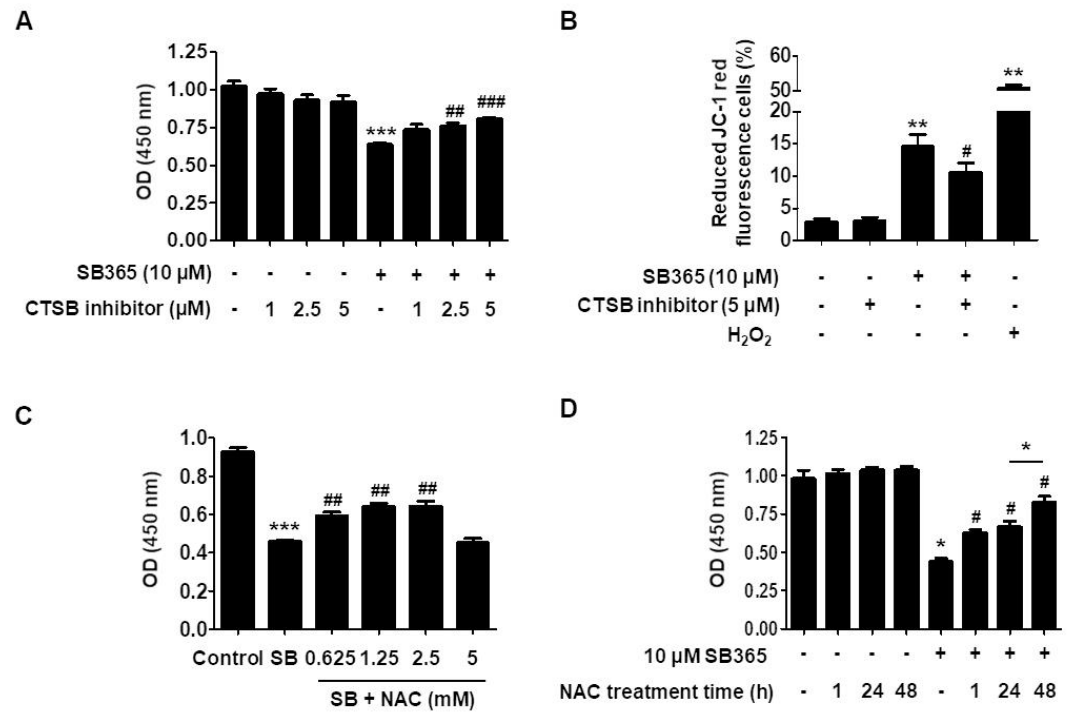
Figure 5. SB365 induced cell death via cathepsin B and ROS in U87-MG cells. ( A ) A cathepsin B inhibitor partially restored inhibited proliferation of U87-MG cells induced by SB365. Cells were cultured in 96-well plates, treated with 10 µ M SB365 for 72 h in the presence of the indicated concentrations of cathepsin B inhibitor, and subjected to CCK-8 assay. ( B ) A cathepsin B inhibitor partially recovered SB365 induced MMP deterioration. U87-MG cells were treated with 10 µ M SB365 for 72 h in the presence of 5 µ M cathepsin B inhibitor, stained with JC-1, and MMP was analyzed by FACS. ( C ) NAC partially reduced the anti-proliferative e ff ect of SB365 in U87-MG cells. Cells were cultured in 96-well plates, treated with 10 µ M SB365 for 72 h in the presence of the indicated concentrations of NAC, and subjected to CCK-8 assay. NAC was added to the culture medium 1 h after SB365 treatment. ( D) The same experiments were performed as in ( C ) with 2.5 mM NAC. However, NAC was treated 24 and 48 h after SB365 treatment, in addition to 1 h treatment. Quadruplicate samples were analyzed independently in triplicate. * p < 0.05, ** p < 0.01, *** p < 0.001 vs the control; # p < 0.05, ## p < 0.01, and ### p < 0.001 vs the SB365 group. CTSB, cathepsin B; NAC, N -acetyl cysteine.